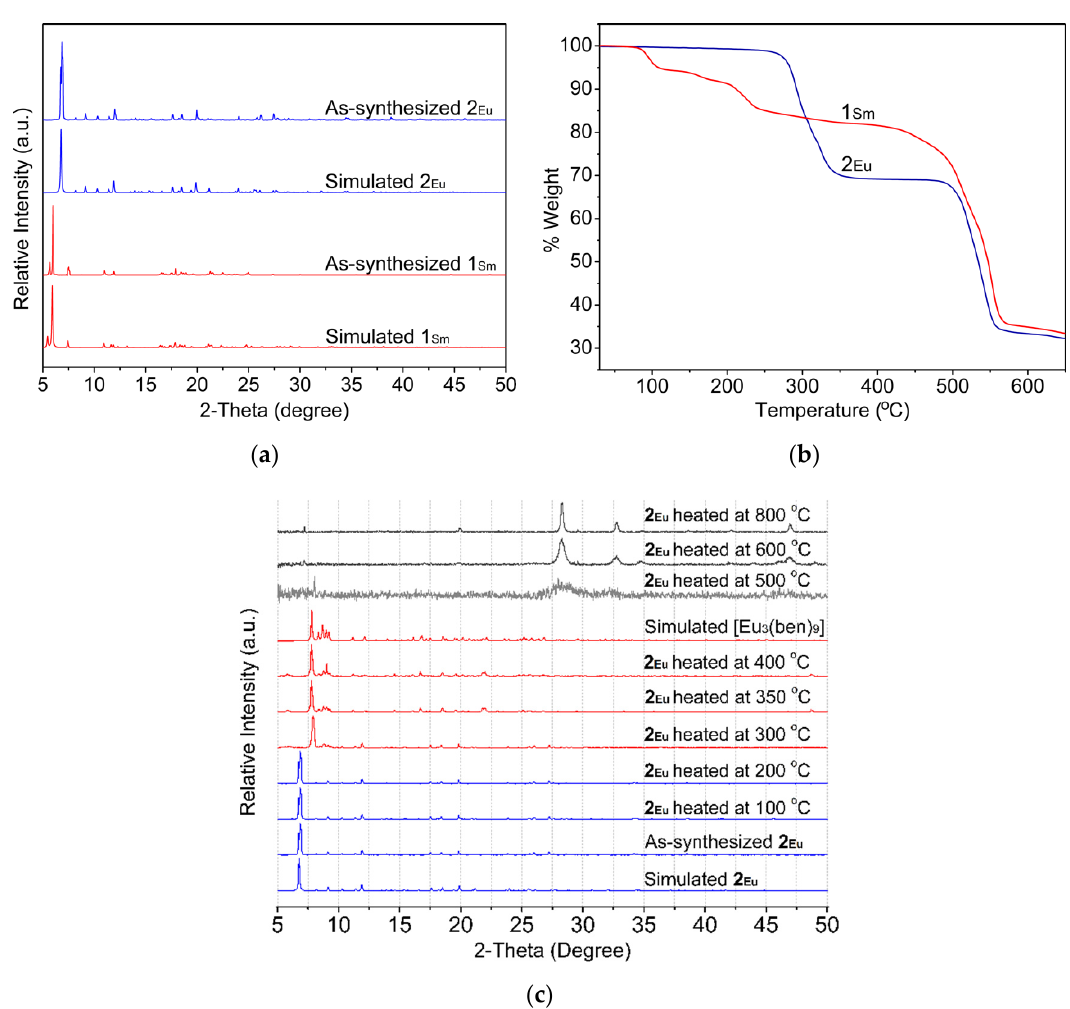
Figure 4. ( a ) Comparison of the experimental PXRD patterns of 1 and 2 with the simulated diffraction patterns from the single crystal X-ray diffraction determination. ( b ) TGA curves of 1 and 2 . ( c ) Variable temperature PXRD patterns of 2 .